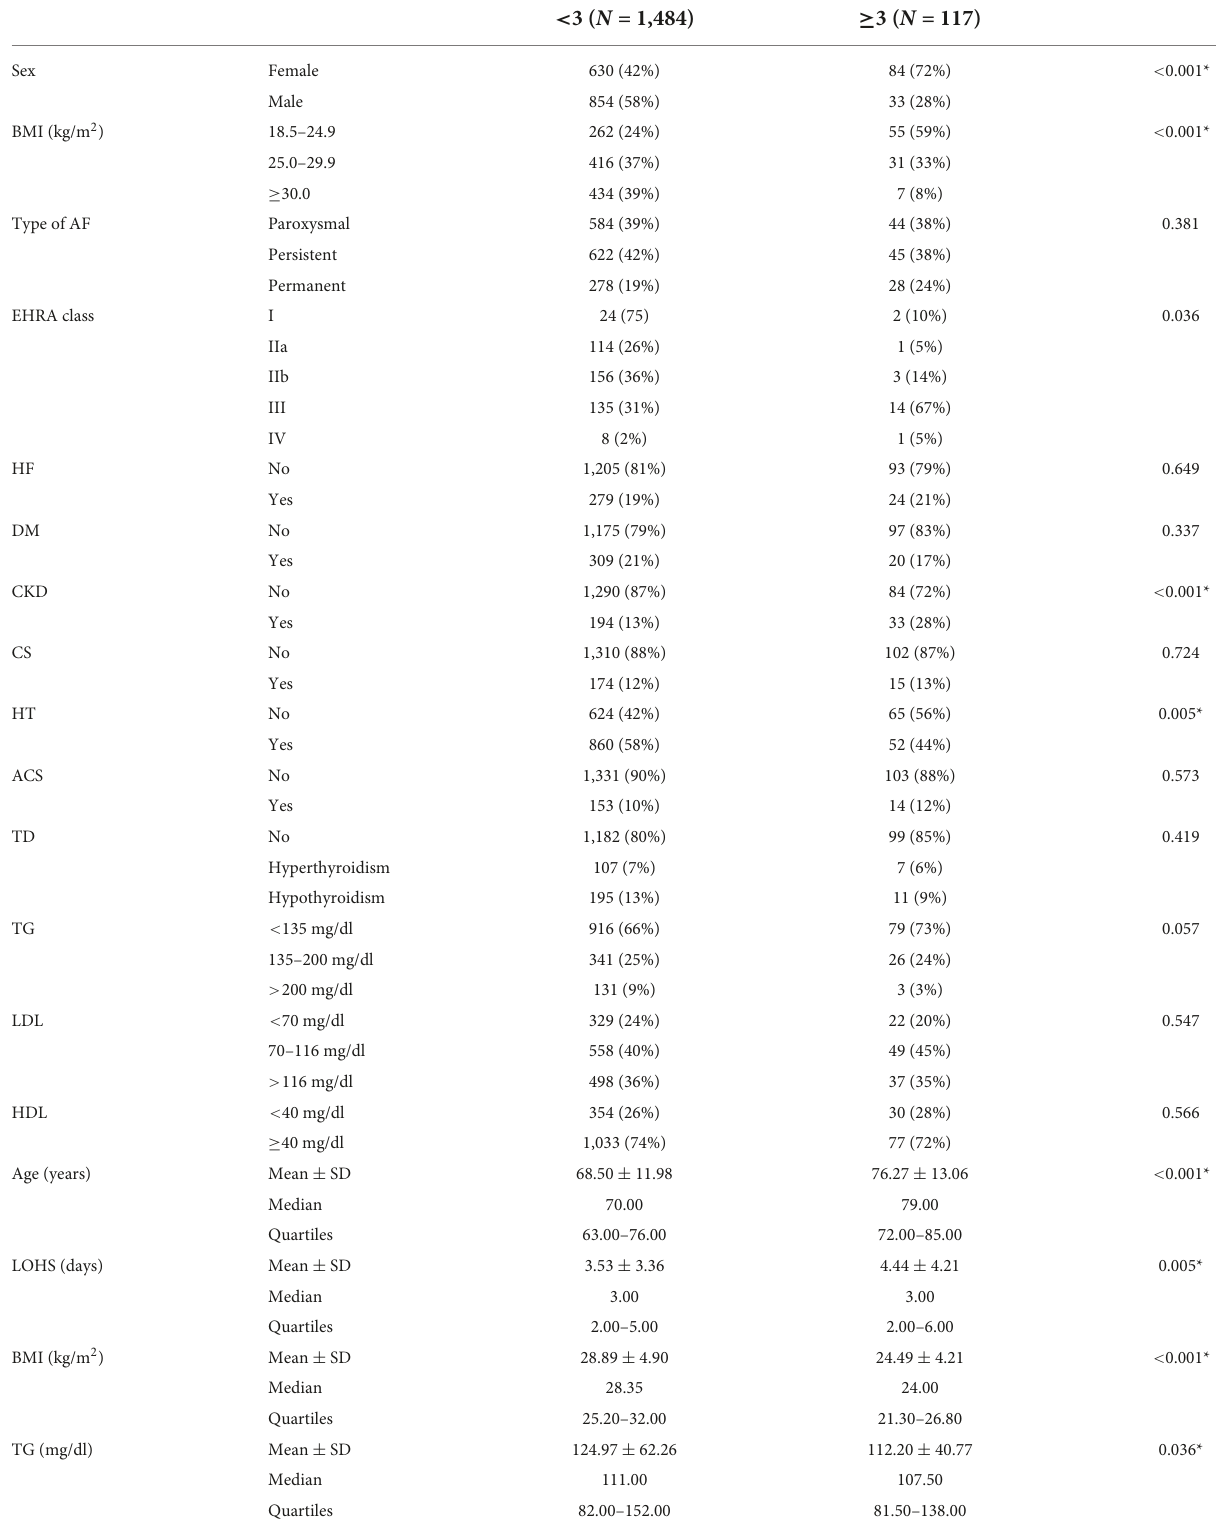
TABLE 3 Comparison of the assessed parameters by NRS